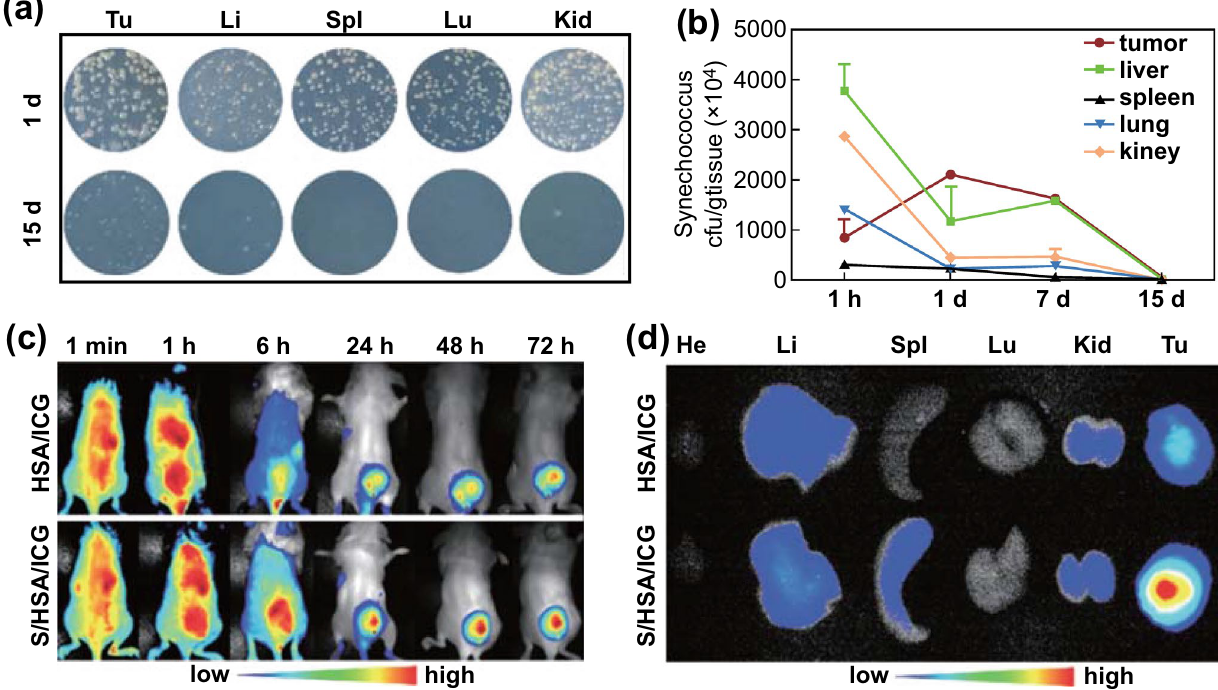
Fig. 6 a Bacterial colony-forming units of tissue homogenates in BG11 solid plates after intravenous injection of HSA/ICG-loaded Syne for 1 and 15 days. b Bacteria growth profiles of different tissues within 15 days. c 4T1 tumor-bearing mice and d major organs after intravenous injec- tion of indocyanine green-encapsulated human serum albumin nanoparticles and HSA/ICG NPs-loaded photosynthetic bacteria. Reprinted with permission from Ref.